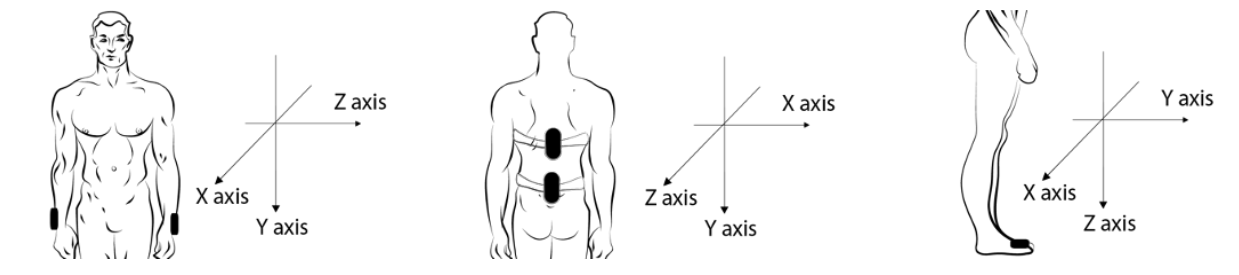
Figure 6. On-body sensors utilised for the activity recognition.